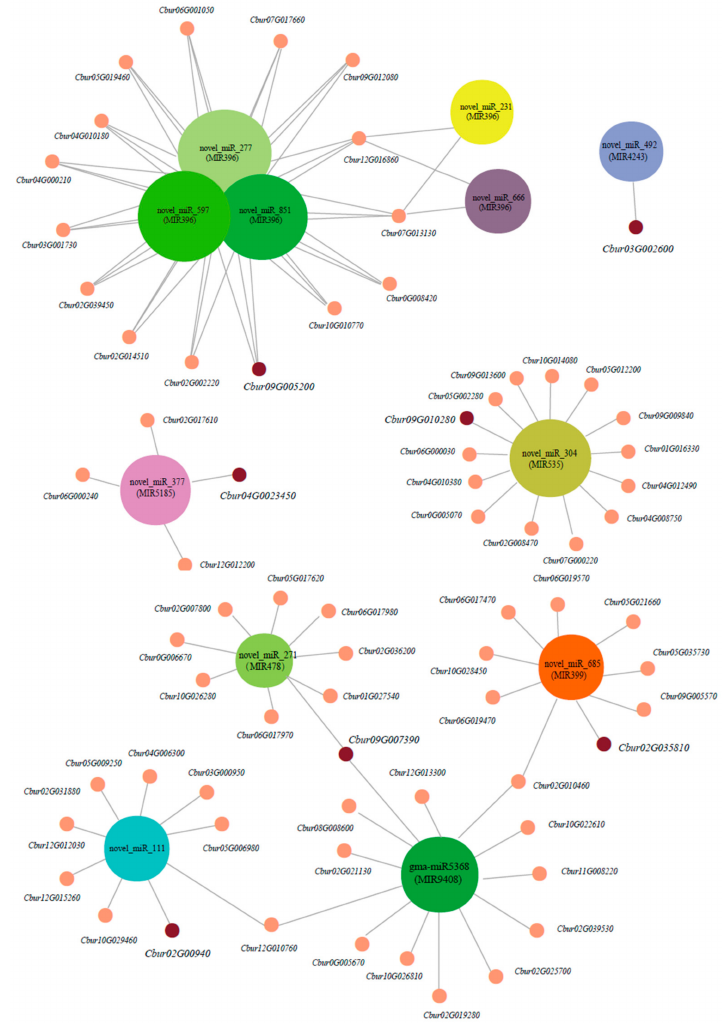
Figure 3. Regulatory network of miRNAs and target genes involved in terpenoid synthesis. The large circles in different colors indicate the various miRNAs detected, and the small circles (in orange and dark red) indicate the predicted target genes. The small dark red circles indicate the seven target genes involved in the synthesis of monoterpenoids and sesquiterpenoids, according to the results in Figure